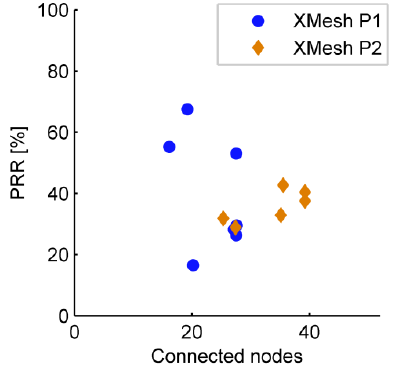
Figure 6. Network PRR versus number of connected nodes in the network when using XMesh. PRRs are computed monthly and the number of connected nodes is computed as the average of daily connected nodes within the network in the same time period.